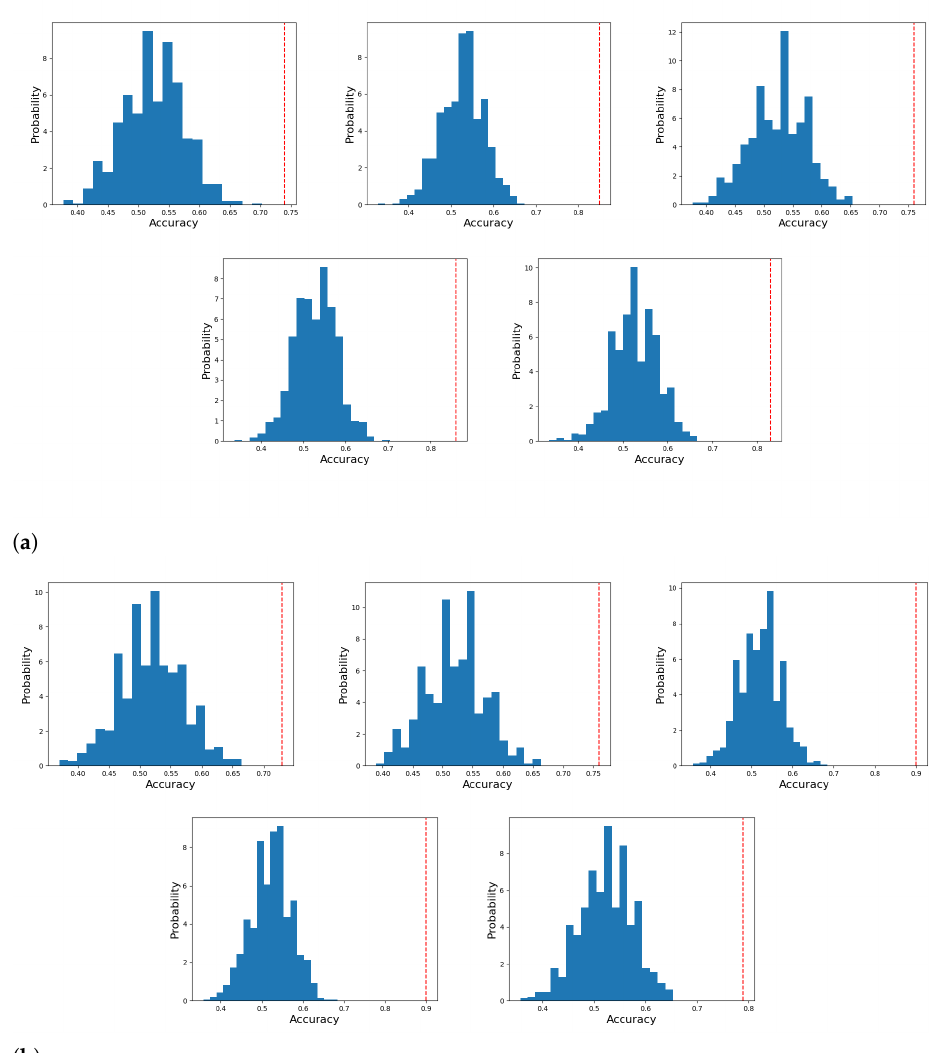
Figure 8. Permutation test results to assess the statistical significance of the results. Blue distribution corresponds to the null distribution and red line corresponds to the accuracy obtained with true labels. The ( a ) 4.8 Hz stimulus and ( b ) 16 Hz